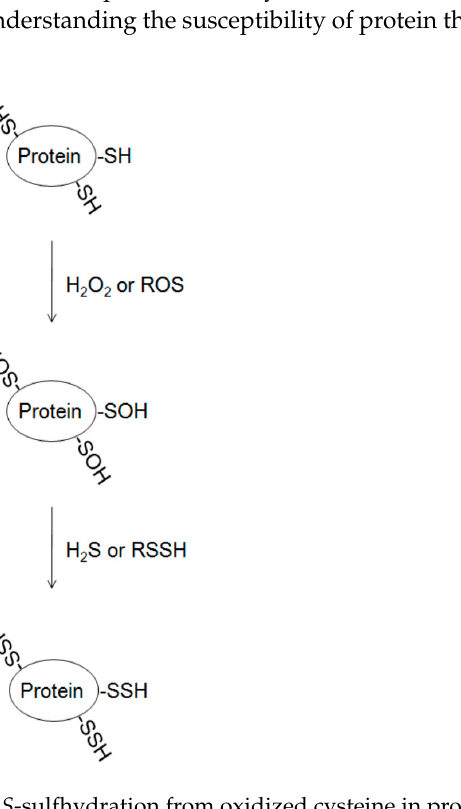
Figure 3. Potential mechanism of protein S -sulfhydration from oxidized cysteine in proteins. H 2 O 2 , hydrogen peroxide; H 2 S, hydrogen sulfide; ROS, reactive oxygen species; RSSH, hydropersulfides.